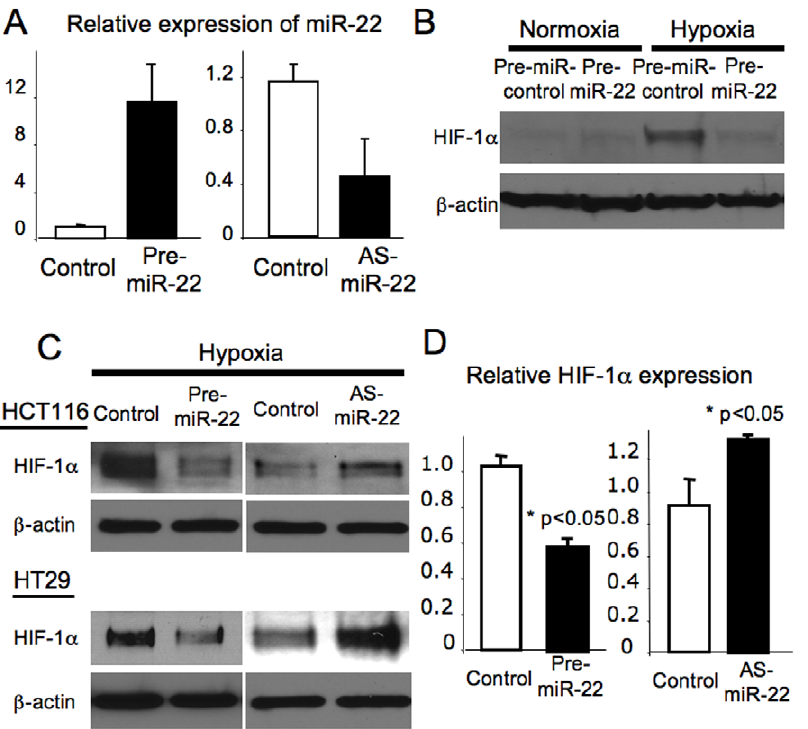
Figure 2. HIF-1 a is a target of miR-22. (A) Alteration of miR-22 expression by transfection. HCT116 cells were transfected with pre-miR-22 or anti- sense-miR-22 or control oligonucleotides, and levels of miR-22 were measured by qPCR. (B) Over-expression of miR-22 inhibits HIF-1 a expression. HCT116 cells were transfected with control oligonucleotides or pre-miR-22, and then exposed to normoxia or hypoxia for 16 h. Cell lysates were immunoblotted for HIF-1 a . Hypoxia induces HIF-1 a , but miR-22 suppresses HIF-1 a . (C) Two colon cancer cell lines, HCT116 (two upper panels) and HT29 (two bottom panels), were transfected with pre-miR-22 or anti-sense-miR-22, exposed to hypoxia, and cell lysates were immunoblotted for HIF- 1 a . (D) Quantification by densitometry of immunoblotting for HIF-1 a in HCT116 cells transfected as above (n=3 6